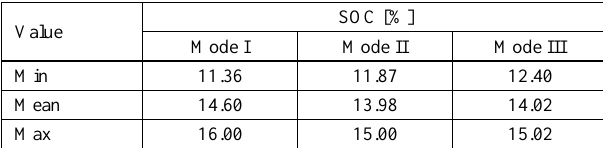
Table 5. SOC changes in the NEDC test in terms of different drive system control